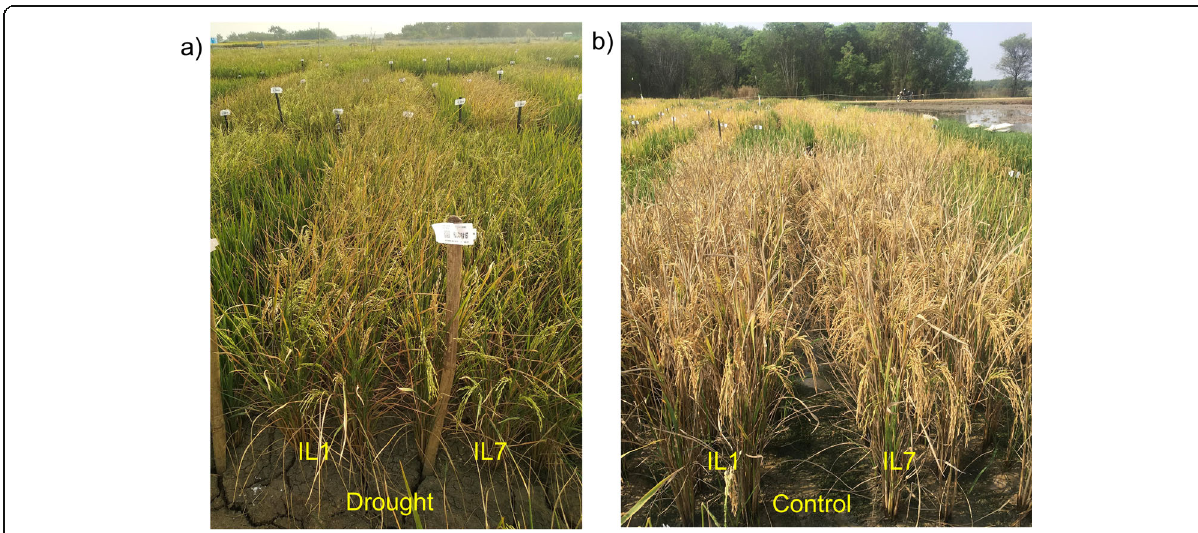
Fig. 4 Field performance of high yielding selected ILs Performance of IL1 (8 QTLs/genes combination) and IL7 (8 QTLs/genes combination) having different combinations have been compared in drought and control conditions during WS2018